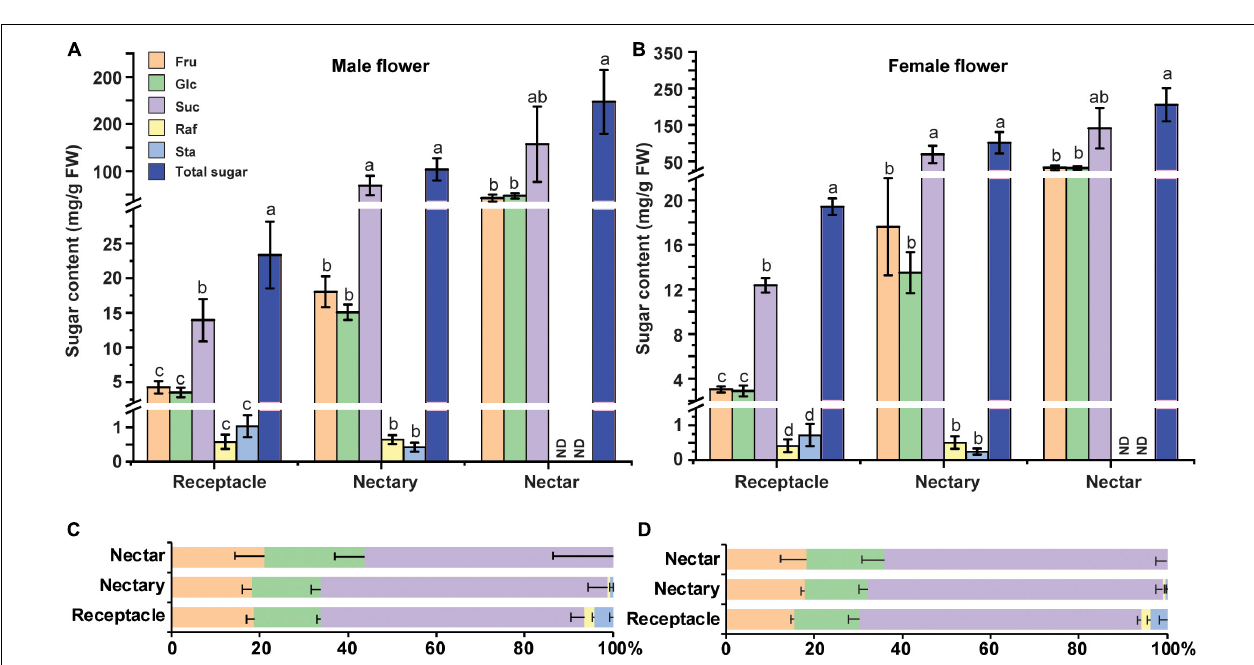
FIGURE 4 | Immunohistochemical localization of CsSWEET7a in female cucumber flowers. Longitudinal (A–E) and transverse sections (F–H) of female flowers with AP as the second antibody. (B,D,G) The close-up of the boxes in panels (A,F) , respectively. The white arrows in panel (D) indicate the sieve plate. (C,E,H) Sections were incubated with pre-immune serum as a control. Images in panels (G,H) were rotated 90 ◦ clockwise. The Roman numerals in red at the top-right corner (B–E,G,H) correspond to those fields in panels (A,F) . Nec, nectary; Re, receptacle; Ph, phloem; Xy, xylem; SP, sieve plate.